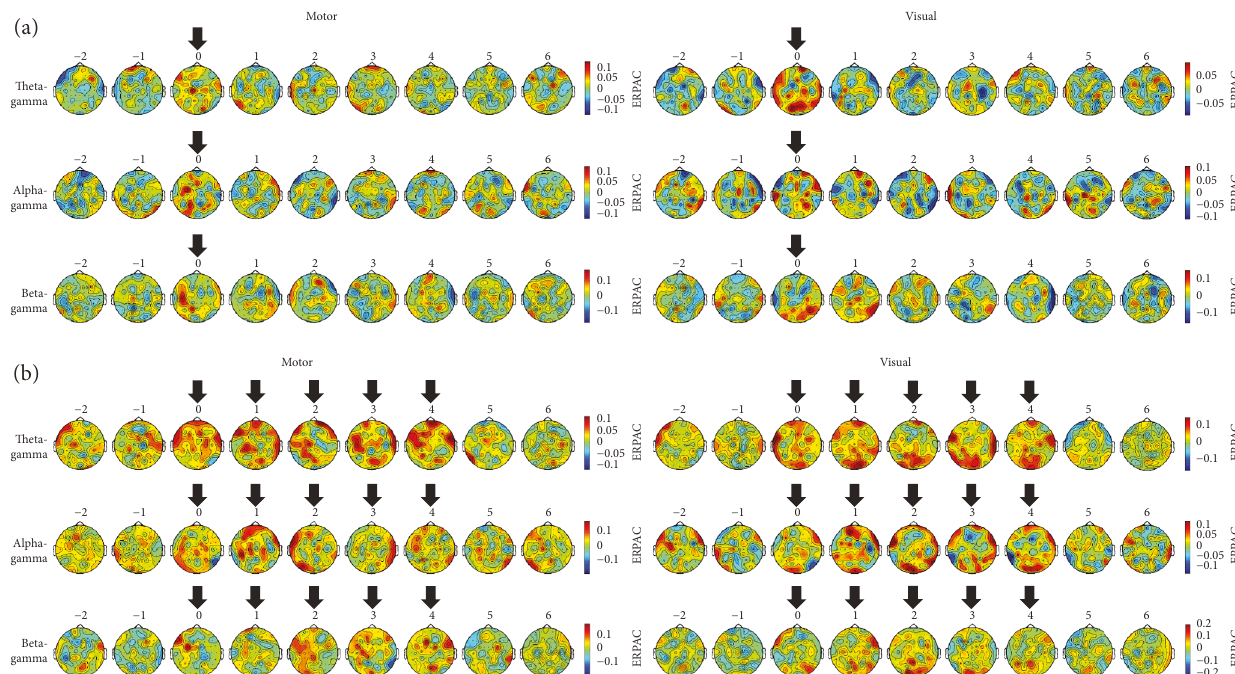
Figure 4: Grand average topographic maps of phase-amplitude coupling. Plots show the strength of motor-TMS-induced (left column) and visual-TMS-induced (right column) theta-gamma ( fi rst row), alpha-gamma (second row), and beta-gamma (third row) event-related phase-amplitude coupling (ERPAC) at all scalp electrodes within nine time windows of interest. Stimulation paradigms are (a) sTMS and (b) rTMS, with the rTMS frequency always corresponding to the frequency of the phase series. We extracted TMS e ff ects by subtracting ERPAC obtained during sham stimulation from that obtained during motor or visual TMS and averaging the resulting values over prede fi ned time windows of interest, positioned at – 2cycles to +6cycles of a condition ’ s phase-providing oscillation around the onset of the fi rst (or single) pulse, over the sixteen amplitude frequencies and fourteen assessed participants. Topographic maps centred on pulses are indicated by black